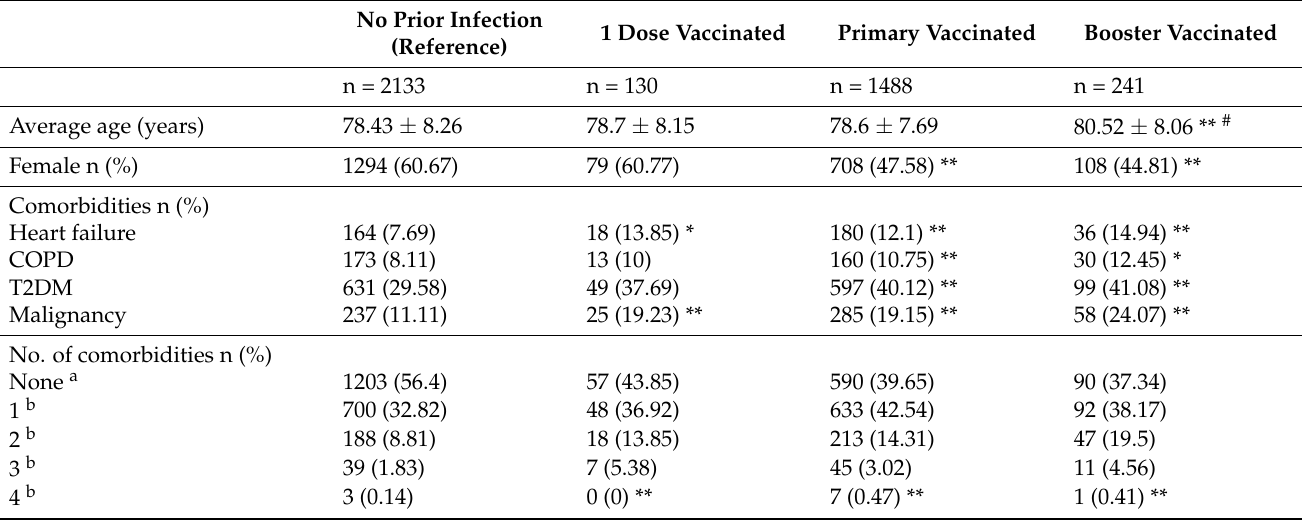
Table 4. Patient characteristics of the 28-day all-cause mortality subgroup following